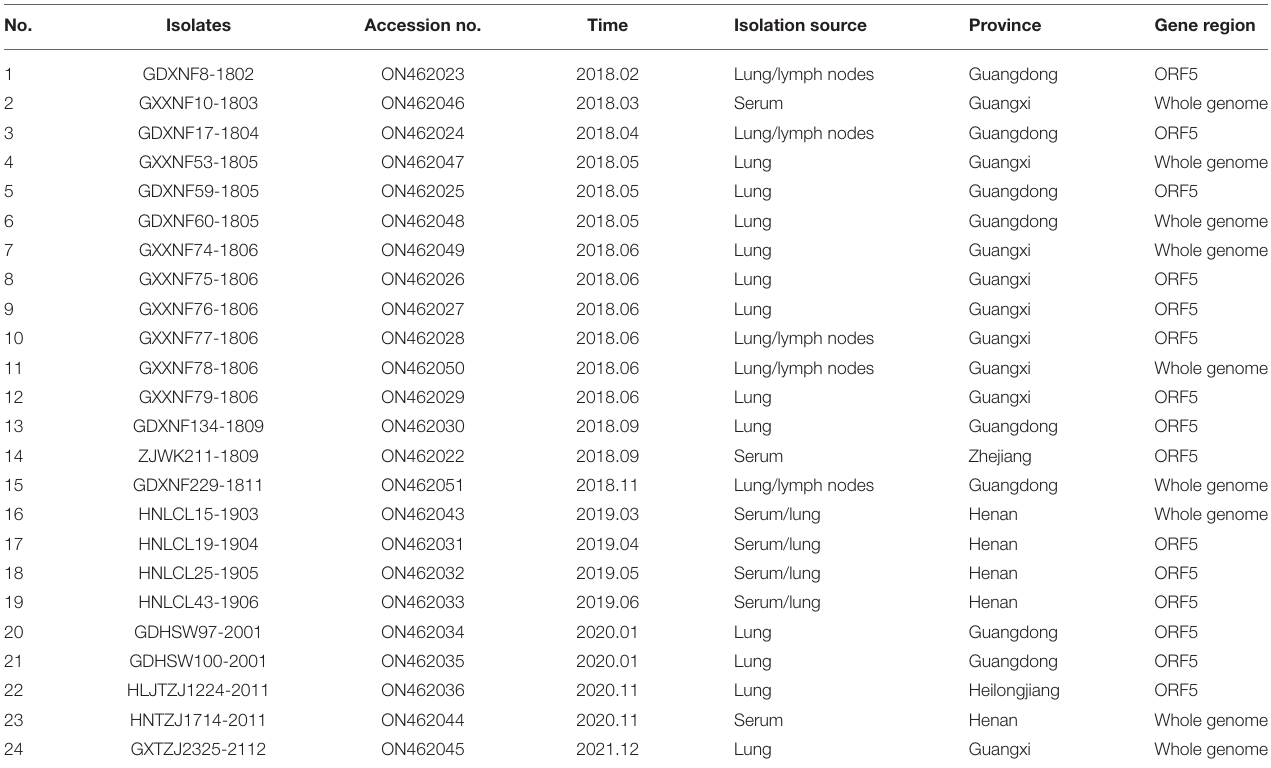
TABLE 1 | Information on 24 strains of the newly identified QYYZ-like